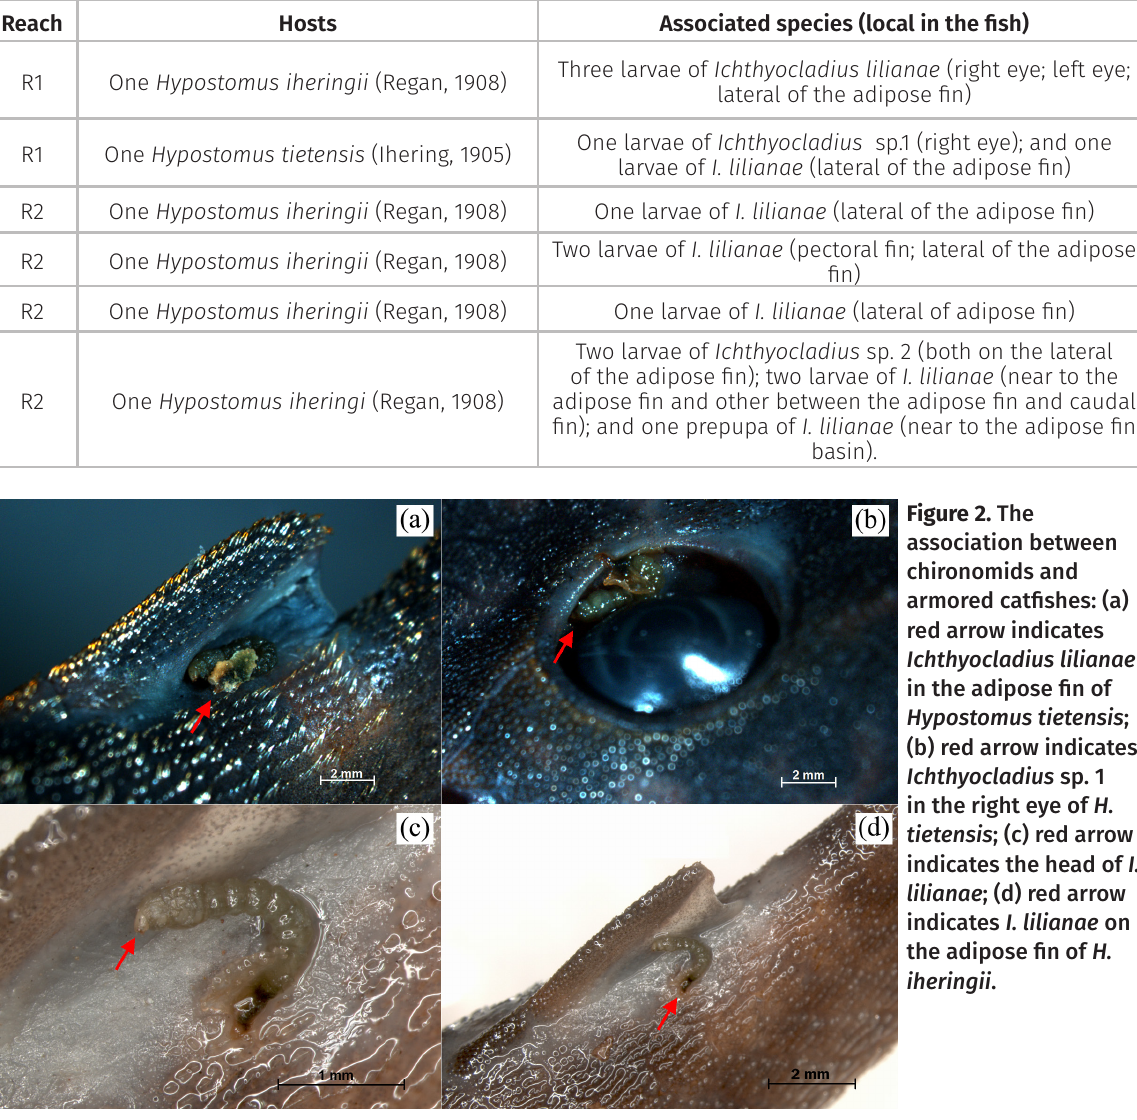
Figure 2. The association between chironomids and armored catfishes: (a) red arrow indicates Ichthyocladius lilianae in the adipose fin of Hypostomus tietensis ; (b) red arrow indicates Ichthyocladius sp. 1 in the right eye of H. tietensis ; (c) red arrow indicates the head of I. lilianae ; (d) red arrow indicates I. lilianae on the adipose fin of H. iheringii